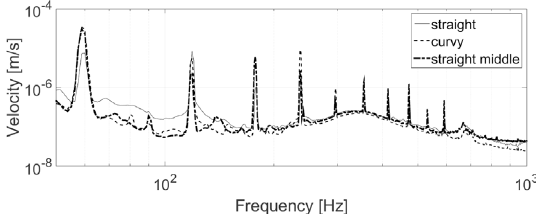
Figure 8. Spectra of the spatial averaging of vibrations in pulsation excited